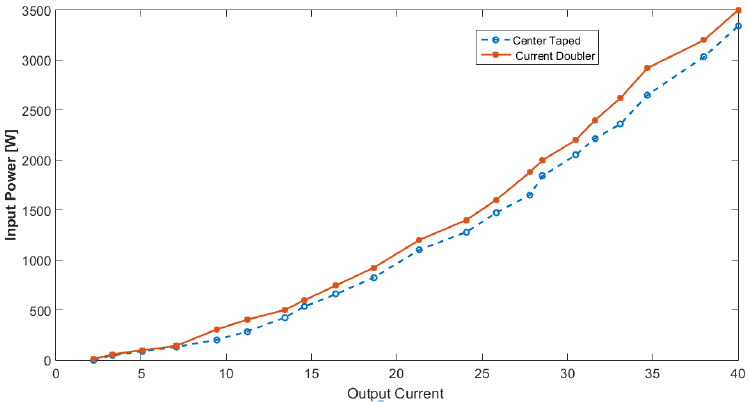
Energies 2020 , 13 , x FOR PEER REVIEW Figure 15. Output power regulation vs. charger output current. Figure 15. Output power regulation vs. charger output current.